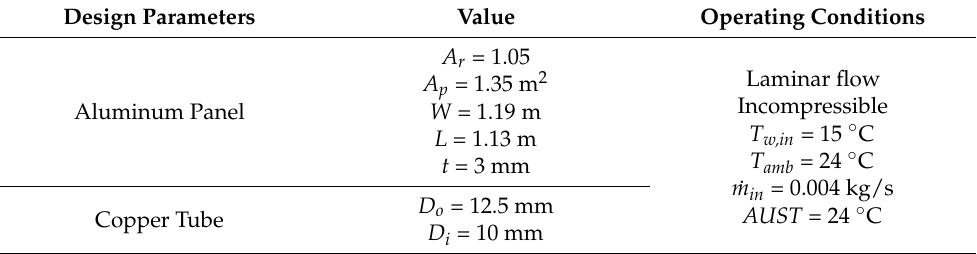
Table 4. Summary of parameters and operating conditions for the simulation.